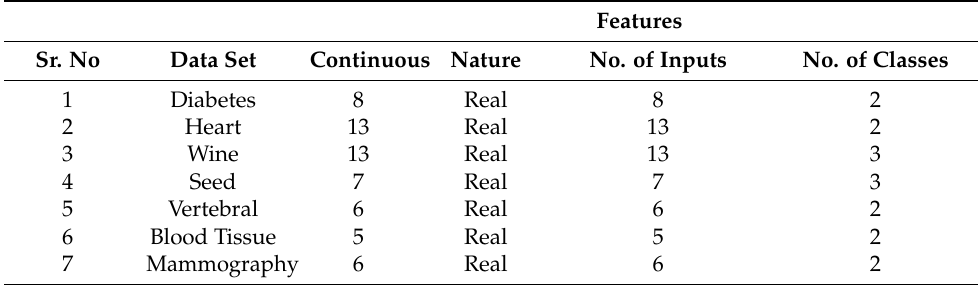
Table 8. Characteristics of UCI benchmarks data